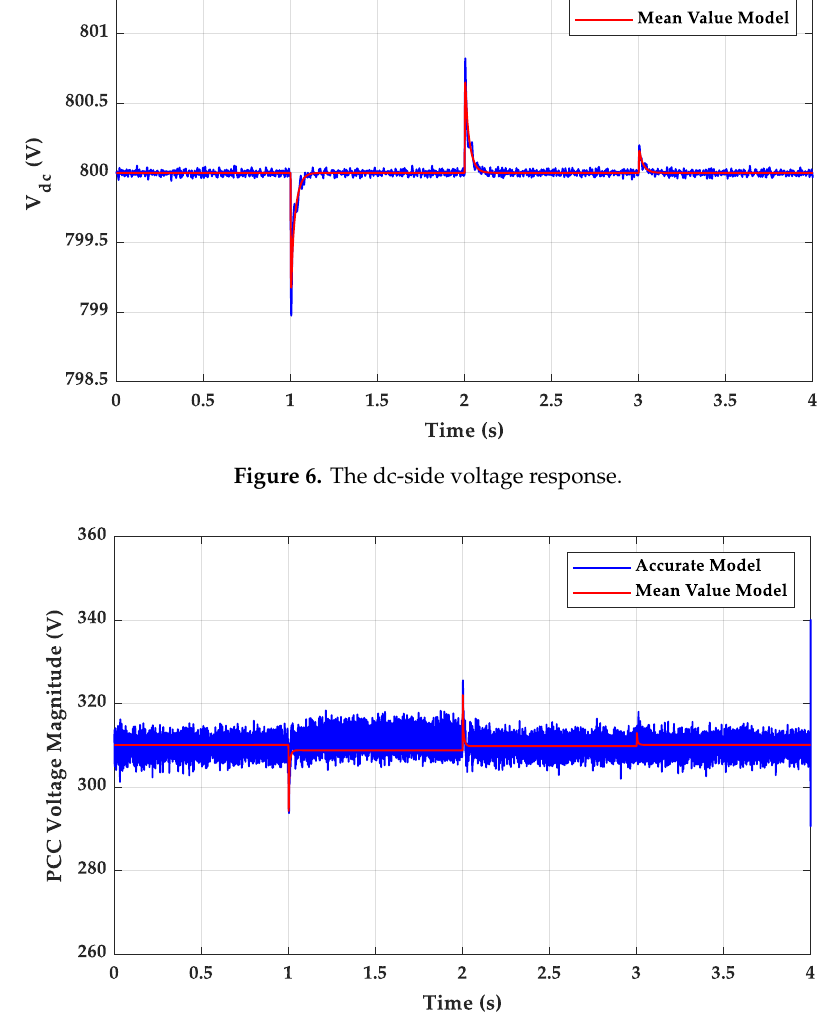
Figure 7. Voltage magnitude response at the PCC.